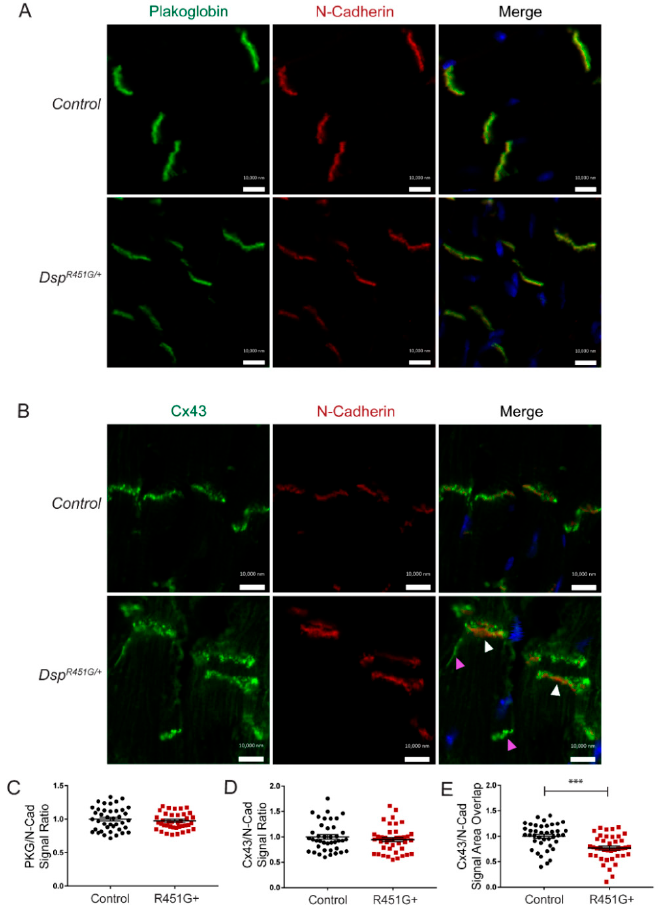
Figure 8. Dsp R451G/+ mice display enhanced mislocalization of Cx43 post TAC surgery. ( A ) IF images of cardiac cryosections isolated from control and Dsp R451G/+ mice 12 weeks post-TAC surgery. Protein targets examined included plakoglobin ( B ) and Cx43. N-cadherin co-stain is used as a control marker. White arrowheads point to increased expression of Cx43 at the ID. Magenta arrowheads point to mislocalization of Cx43 away from the ID. Scale bars represent 10 µ m. n = 4 per